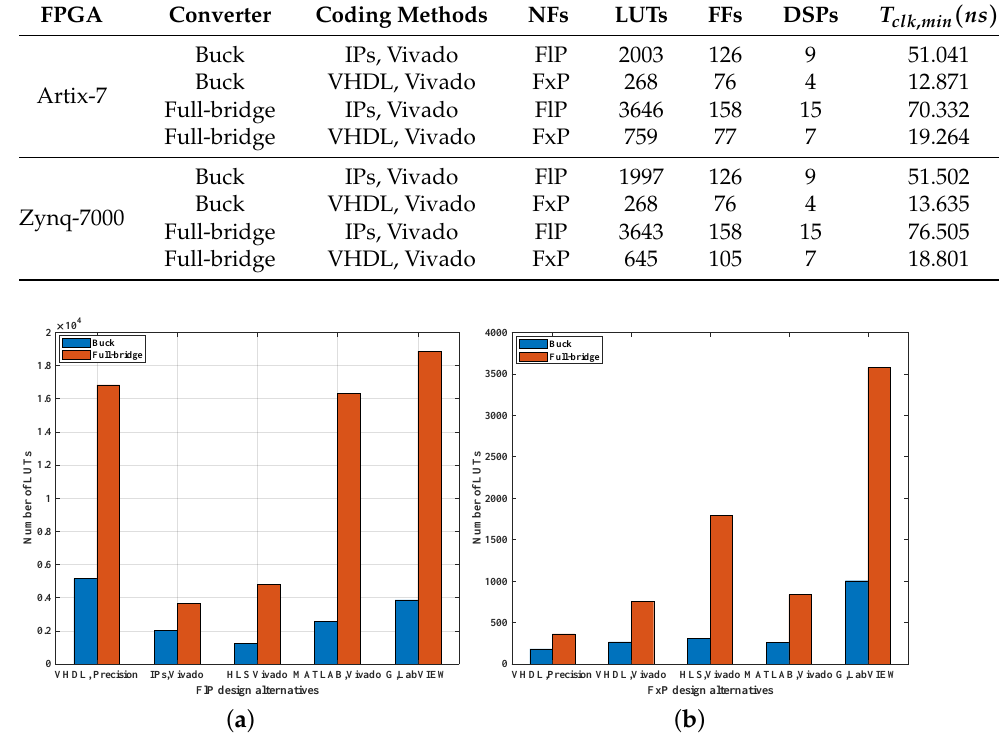
Table 8. Synthesis results comparison between Artix-7 and Zynq-7000.